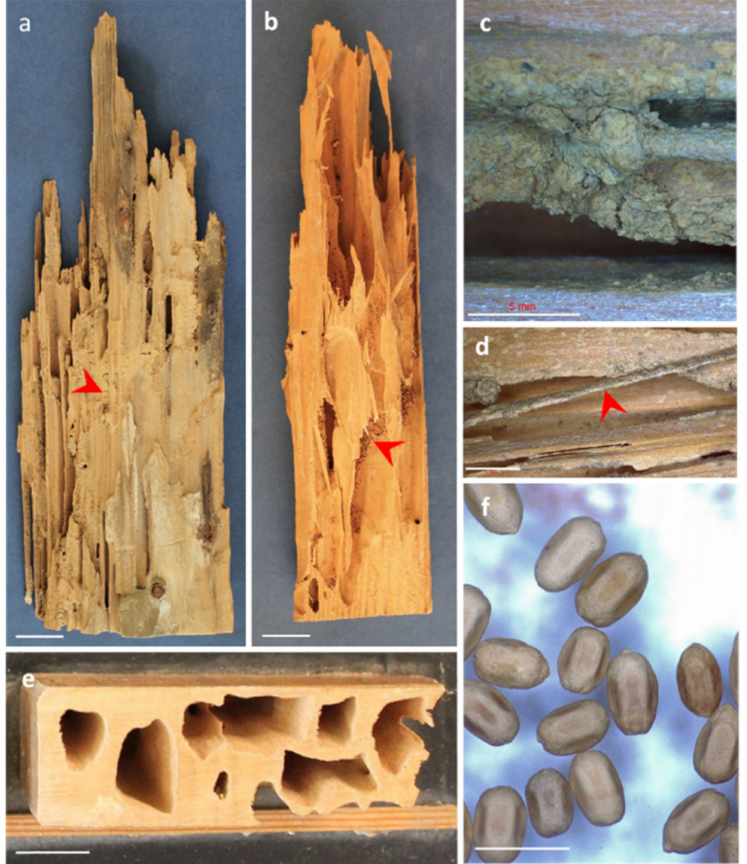
Figure 4. Features of wood attacked by termites present in Europe. ( a ) Wooden piece attacked by subterranean termites (Rhinotermitidae). Note the presence of mud in the galleries (arrowhead). Bar = 2 cm. ( b ) Wooden piece attacked by dry-wood termites (Kalotermitidae). Note the presence of dust excrement in the galleries (arrowhead). Bar = 2 cm. ( c ) Detail of a gallery of subterranean termites covered by mud. Bar = 5 mm. ( d ) Thin layer of wood (arrowhead) usually left by sub- terranean termites during their attack. This layer usually corresponds to latewood. Bar = 5 mm. ( e ) Cross-section of a wooden piece attacked by dry-wood termites and showing internal galleries. Bar = 2 cm. ( f ) Dust excrements of Kalotermitidae in the form of hexagonal prisms. Bar = 1